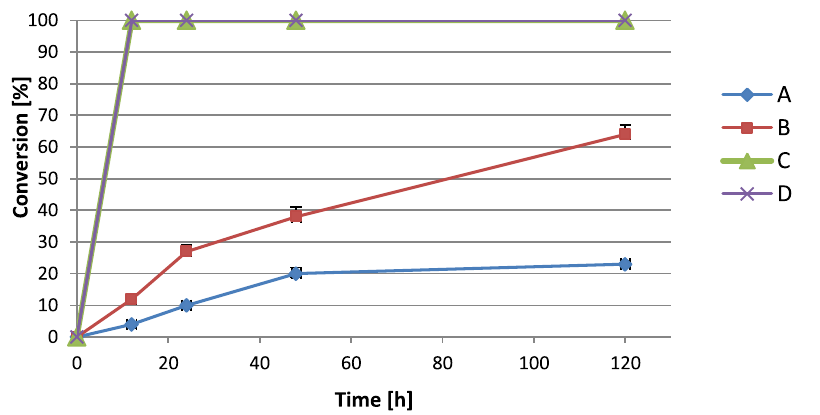
Figure 4. Time-course of the reduction of massoia lactone ( 1 ) with immobilized cells of E. coli BL21(DE3)/ pET30a-OYE3 in batch mode. ( A ) 200 mg immobilized biomass without glucose, ( B ) 400 mg immobilized biomass without glucose, ( C ) 200 mg immobilized biomass with glucose, ( D ) 400 mg immobilized biomass with